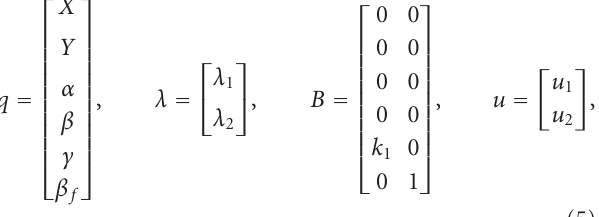
Figure 11: Real GYROBO II.